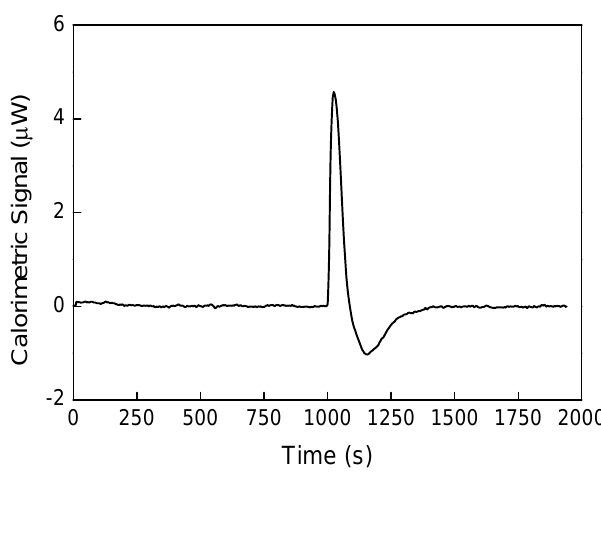
Figure 5. Calorimetric signal of the titration of toluene with toluene at 30 ° C. The volume of titration was 200 μ